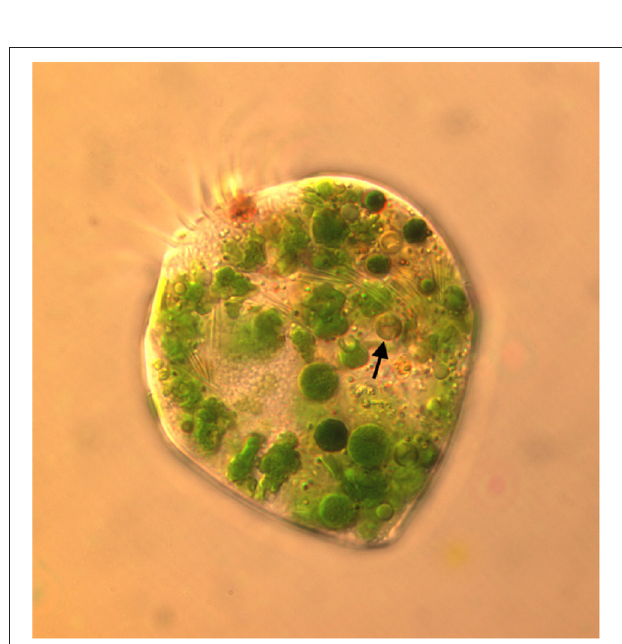
FIGURE 5 | Micrograph of S. razoulzadegani fed Tetraselmis chui (PLY 429), showing variety of shapes and sizes of retained chloroplasts, including smaller dark green and brownish ones (arrow) that may be older than the larger “grass-green”